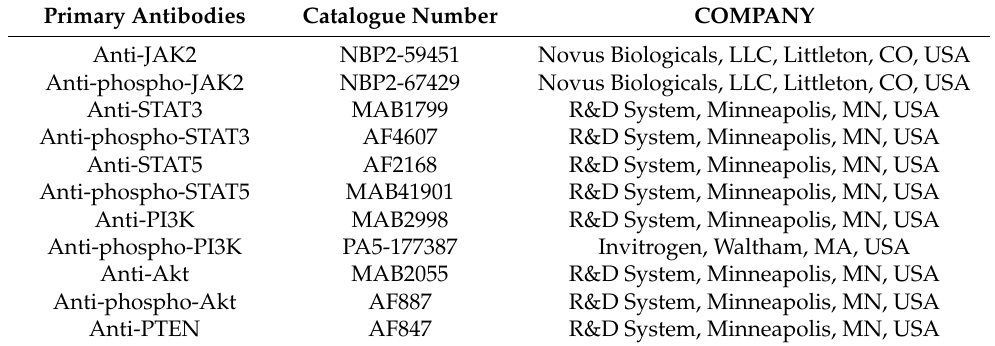
Table 4. List of primary antibodies used for Jess simple western analysis. Primary